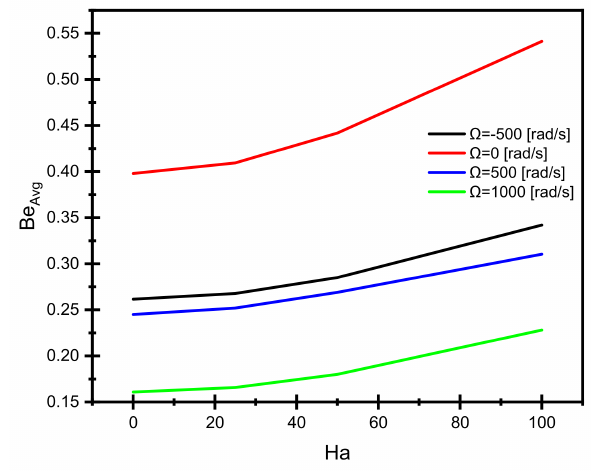
Figure 8. Effect of the Hartmann number on the average Bejan number at different values and directions of the cylinder rotation.